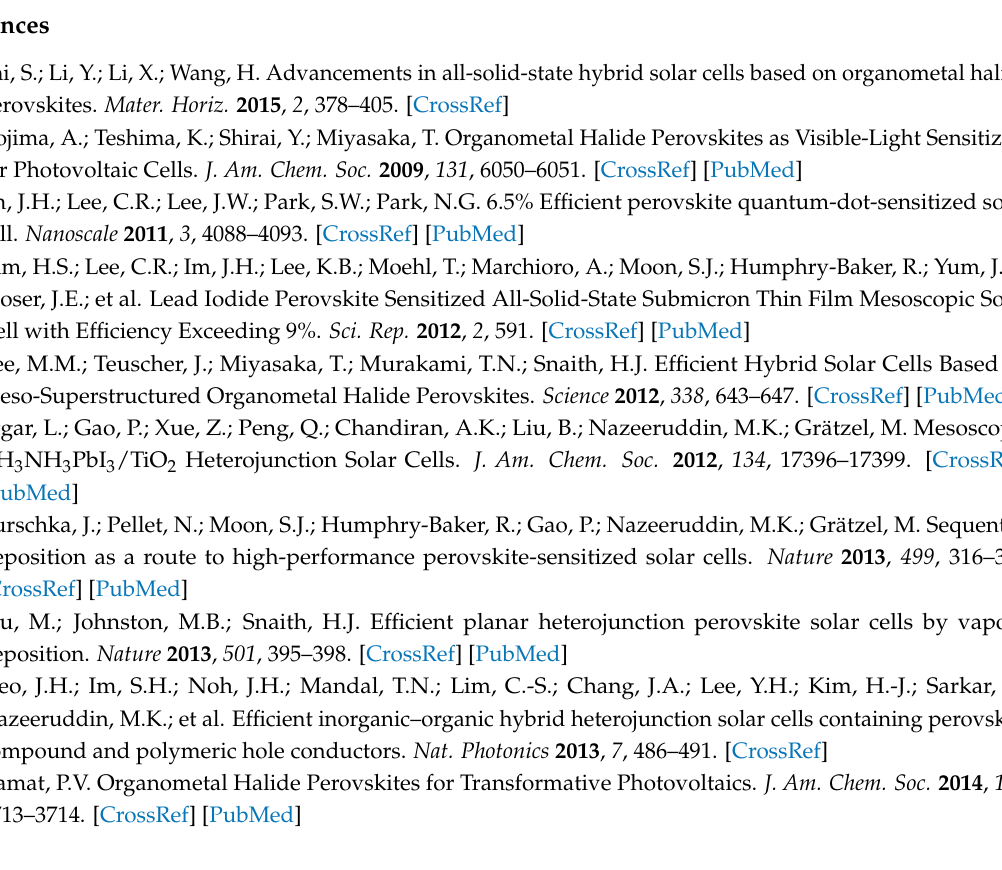
Figure S1: Optical microscopy and PL mapping images of 2D CH 3 NH 3 PbI 3 perovskite, Figure S2: Optical microscopy and PL mapping images of the converted 2D CH 3 NH 3 PbI 3 perovskite without supplying sufficient CH 3 NH 3 I molecules during the conversion process, Figure S3: supplementary photoelectrical performance of the 2D CH 3 NH 3 PbI 3 platelet